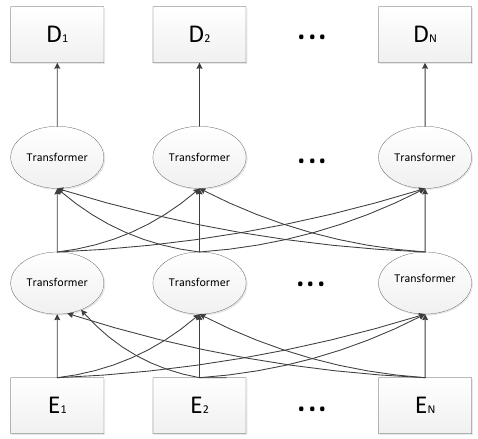
Figure 1. The BERT pre-trained language model [16].